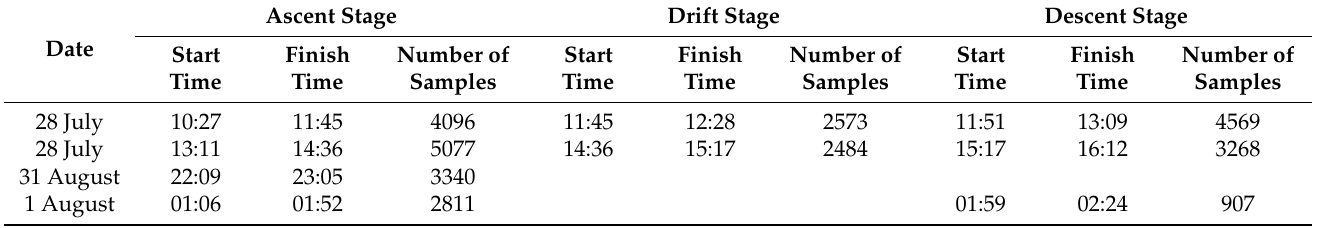
Table 1. Statistics of the intelligent, two-way horizontal drifting radiosonde system deployed from the Xisha Meteorological Observing Station. Note that all times refer to local standard time (LST).